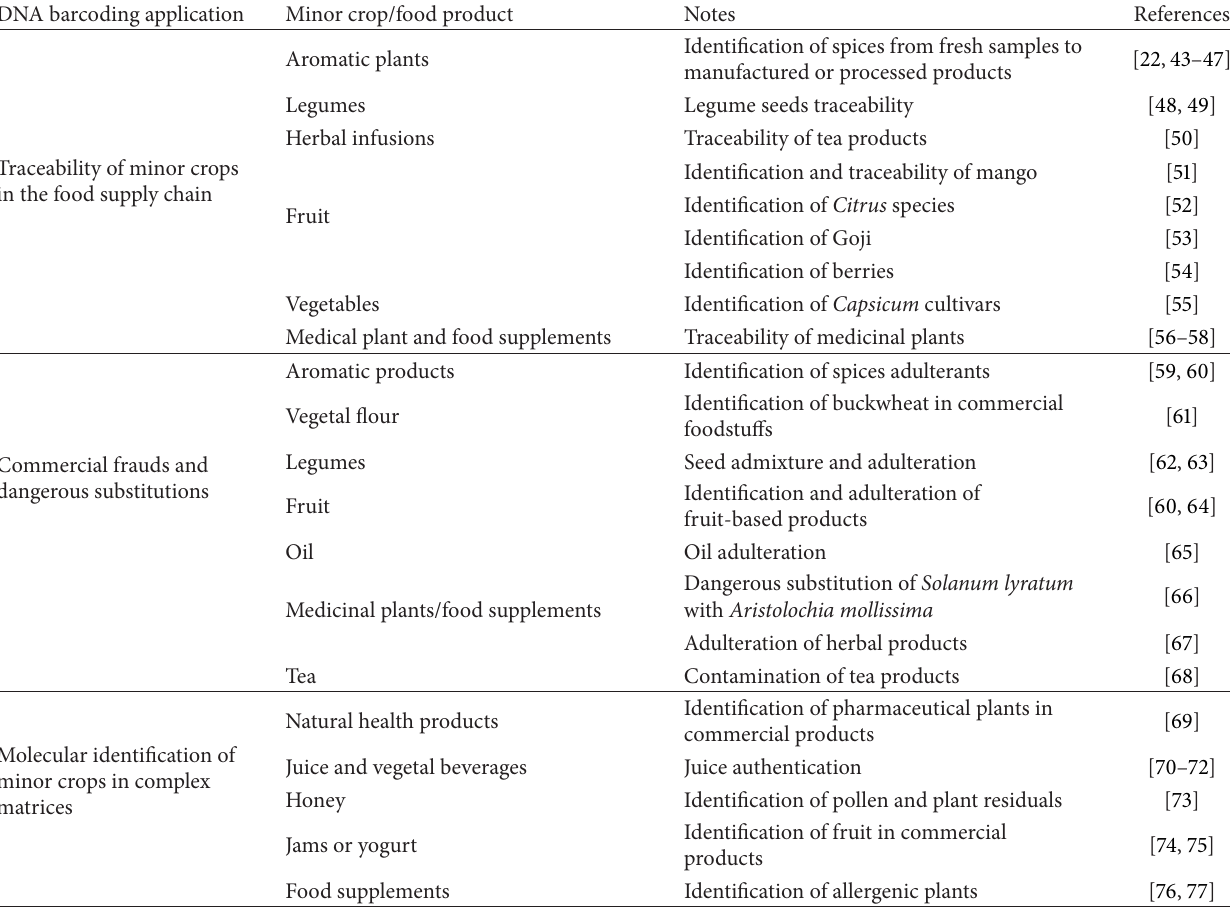
Table 1: List of studies dealing with DNA barcoding identification of minor